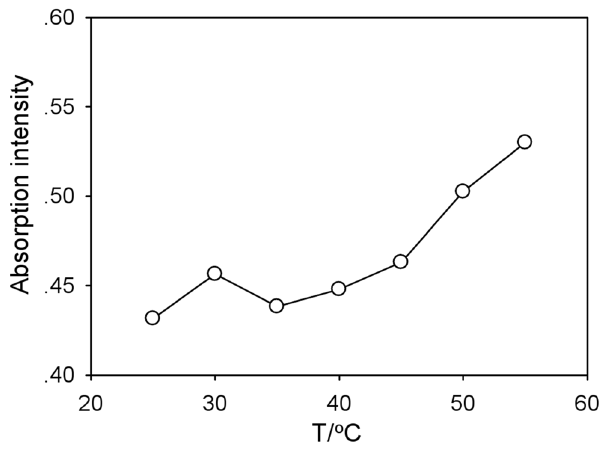
Figure 3. Thermal denature curve of 21bp DNA fragment in 95% DMF. C=20 m g/mL.